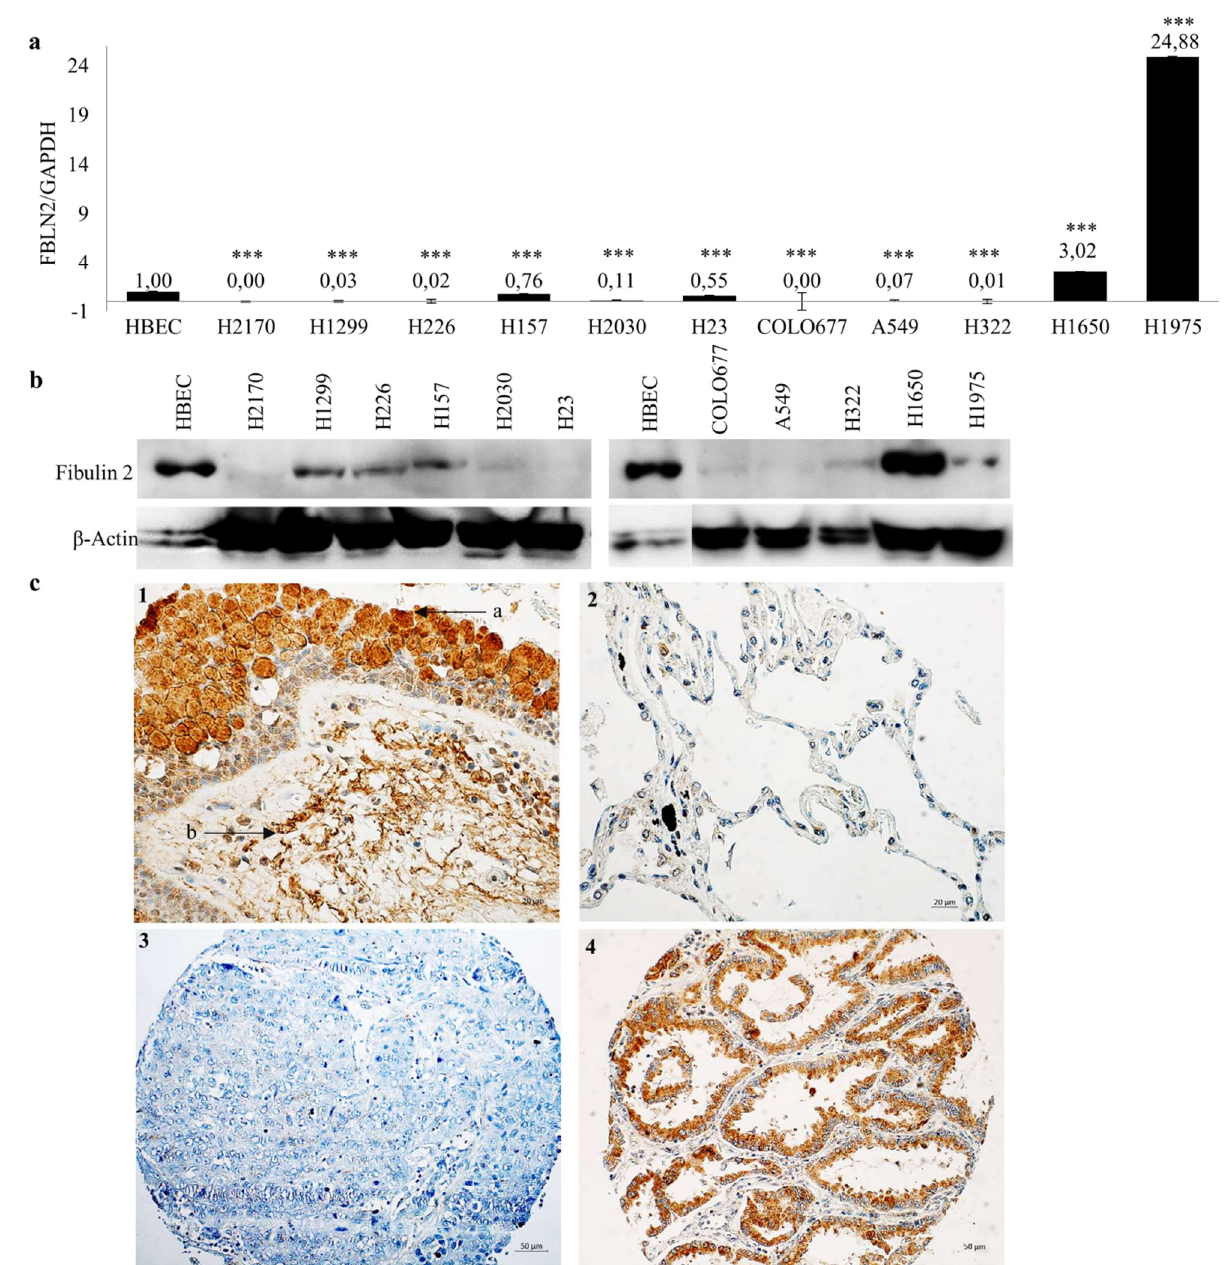
Figure 1. FBLN2 expression in human lung cancer cell lines, normal lung tissue and primary lung tumors. FBLN2 expression in HBEC and lung cancer cell lines was determined by using real-time RT-PCR ( a ) and WB ( b ). The FBLN2 mRNA expression level compared to the expression level of the internal control glyceraldehyde 3-phosphate dehydrogenase (GAPDH) in HBECs was defined as 1.0, *** p < 0.001. β-actin was the loading control for WB; ( c ) Representative immunohistochemical staining of fibulin 2 in normal lung tissue and primary lung tumors. 1-a: Bronchial epithelial cells, 1-b: Stroma tissues. Magnification: 400×. Scale bar: 20 µm. 2: Alveoli. Magnification: 400×. Scale bar: 20 µm. 3: SCC, score 0. Magnification: 200×. Scale bar: 50 µm. 4: ADC, score 3. Magnification: 200×. Scale bar: 50 µm. In the lung tissues with normal histology adjacent to the tumors, fibulin 2 is highly expressed in bronchial epithelial cells and in the stroma tissues (Figure 1c), however,